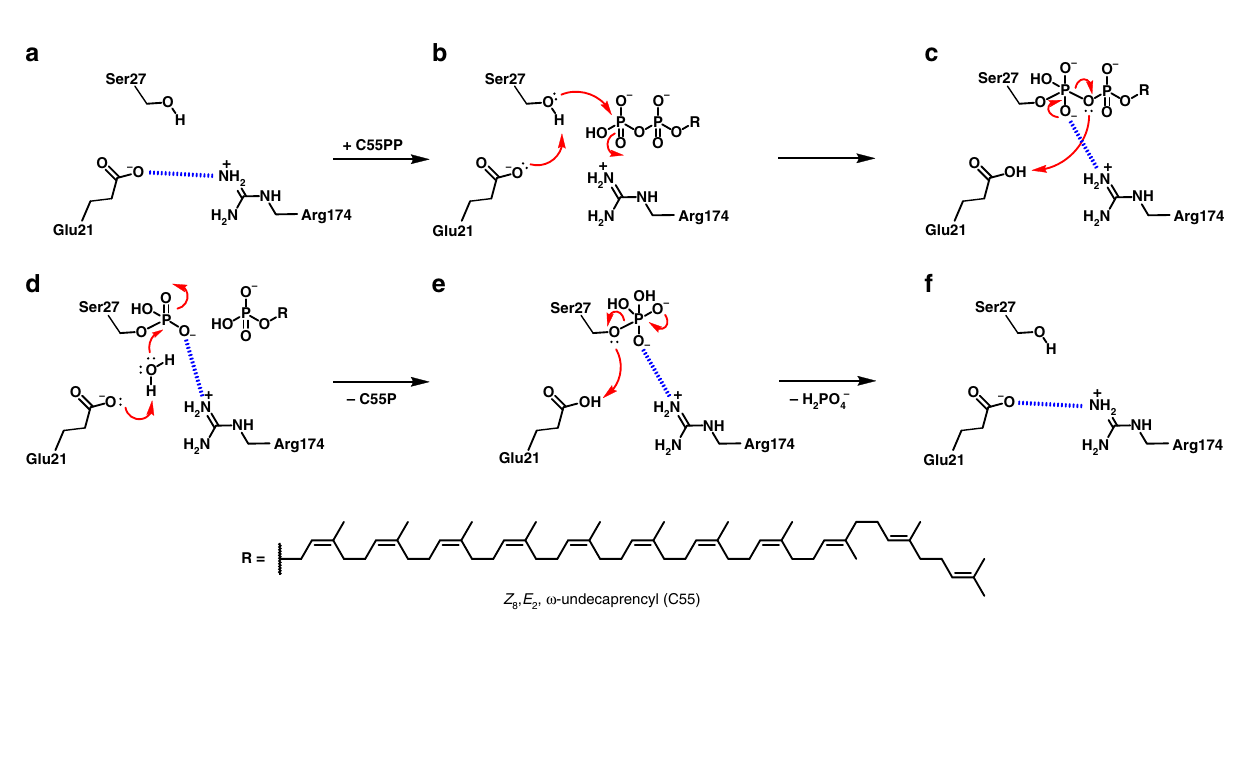
Fig. 8 Proposed undecaprenyl-pyrophosphate phosphatase reaction mechanism in BacA. a Empty active site. Glu21 and Arg174 form a salt bridge as indicated by a blue dashed line. b Michaelis complex with C55PP. Glu21 serves as a proton acceptor that facilitates the nucleophilic attack of the hydroxyl group of Ser27 at the β -phosphate of C55PP. c Collapse of the pentavalent intermediate, phosphorylation of Ser27 and cleavage of the pyrophosphate bond. Upon disruption of the salt bridge between Glu21 and Arg174, the latter can stabilize the pentavalent intermediate in close proximity via ionic interactions. d Product complex. Hydrolysis of the phosphate group at Ser27 is mediated by a water molecule. Stabilization of the pentavalent intermediate by Arg174 potentially facilitates the exit of the product C55P from the active site. e Collapse of the second pentavalent intermediate. f Empty active site ready to undergo another reaction cycle. Calcium likely plays a role in catalysis by coordinating with the polar head groups of C55P and C55PP and the pyrophosphate pentavalent intermediate. Electron lone pairs are shown as double dots. Red curved arrows indicate electron fl ow. Dashed blue lines denote ionic interactions. R represents the polyisoprenyl chain of C55 with the double bond con fi guration of bacterial Z 8 , E 2 , ω -undecaprenol (structure in inset at bottom). See also Supplementary Movie 1 and Supplementary